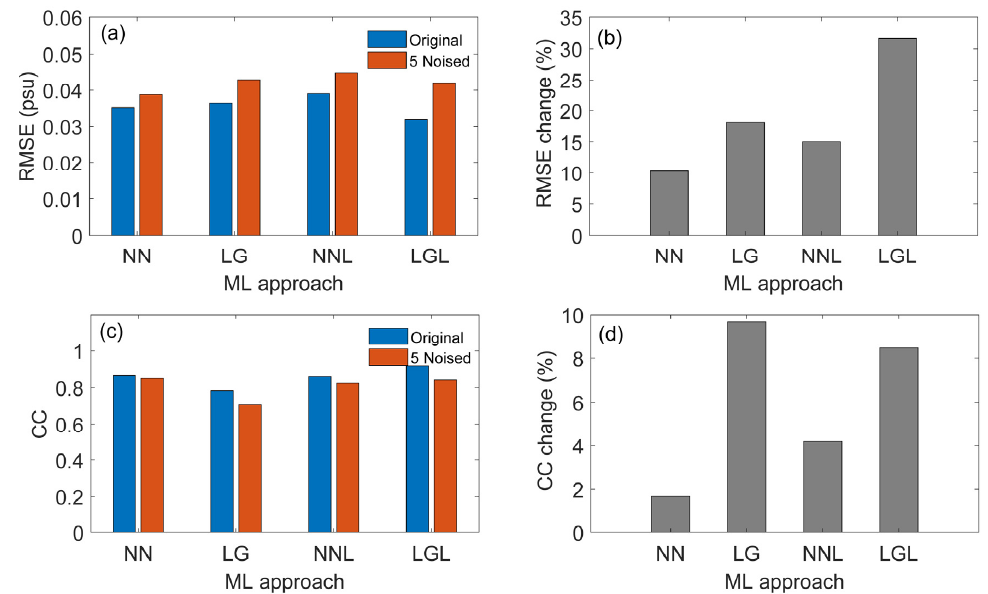
Figure 12. ( a , c ) Bar graphs of average RMSEs and CCs in the 1–2000 m depth range of the four reconstruction experiments performed with the original synthetic dataset and the large-noise synthetic dataset (5 × IAP 1_ std × ε noise added to the true value). ( b , d ) Noise-induced RMSE and CC degradations.